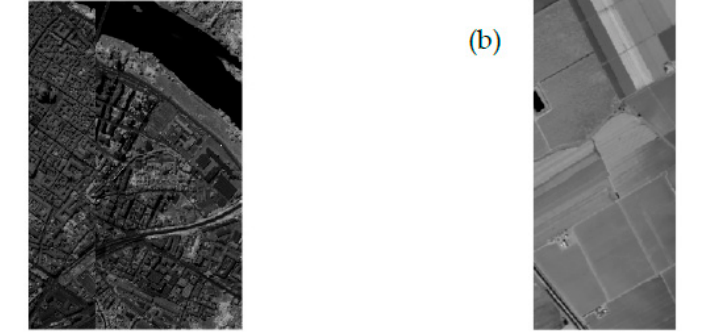
Figure 5. ( a ) Two concatenated images of the Pavia center in Italy. ( b ) Salinas scene of the Salinas valley,